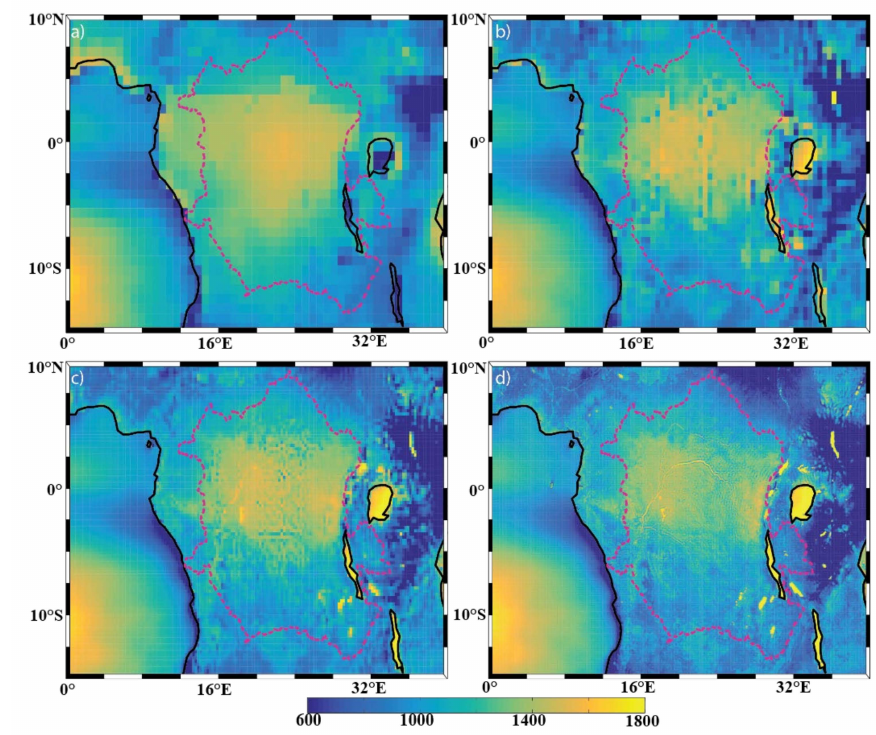
Figure 5. Spatial distribution of annual mean evaporation (mm/y) of the ( a ) ERA-I; ( b ) EERA5; ( c ) ERA5; and ( d ) ECOA datasets from 2016–2017. The Congo Basin is outlined with a dotted